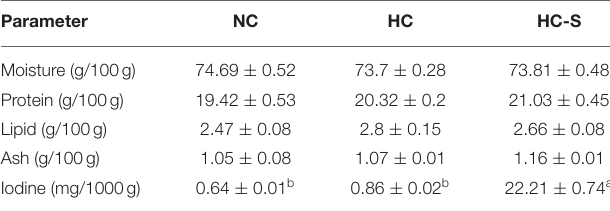
TABLE 3 | Effects of dietary SJ on muscle nutritional values of swamp eel fed HC diet.